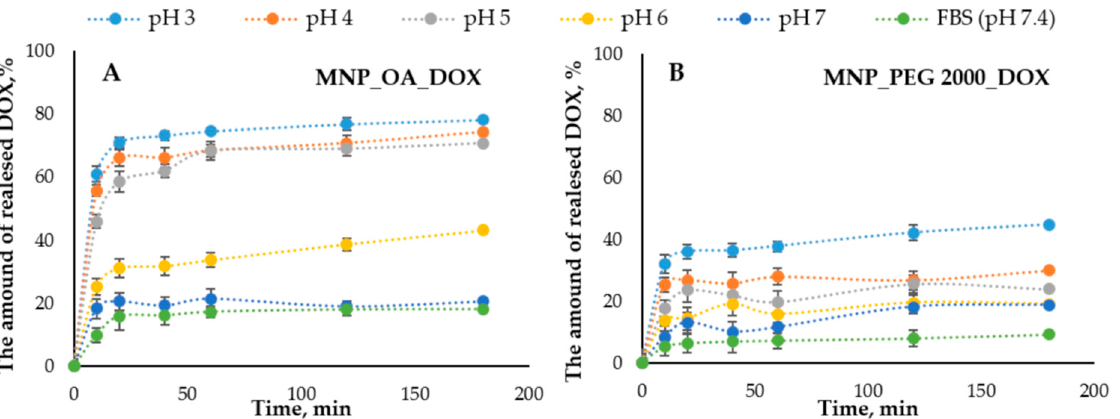
Figure 7. The DOX release percent versus time graphs in the pH 3.0–7.4 range. ( A ) MNP_OA_DOX and ( B ) MNP_PEG 2000_DOX. and ( B ) MNP_PEG